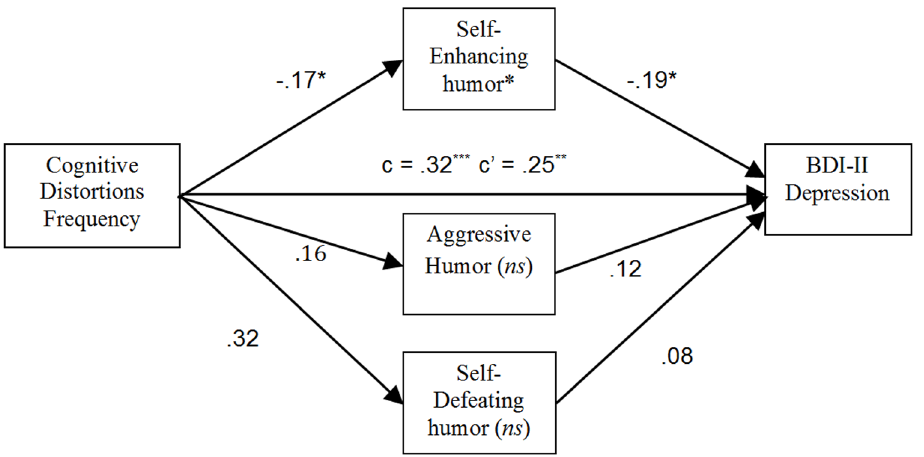
Figure 1. Mediating effect of Self-Enhancing humor on the relation between frequency of cognitive distortions and depressive symptoms.